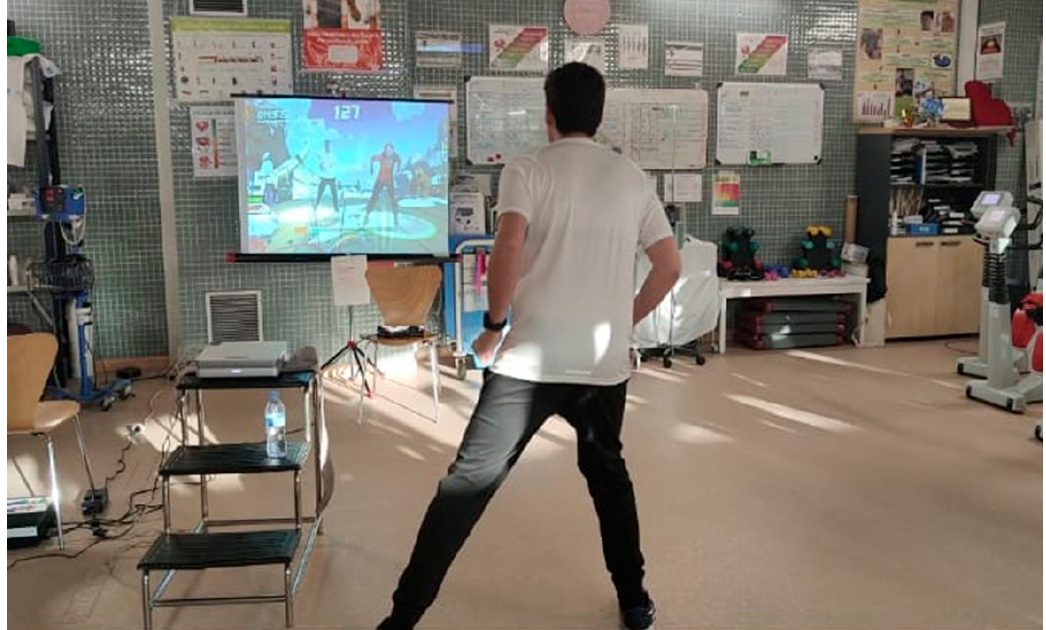
Figure 2. Patient performing the experimental protocol.